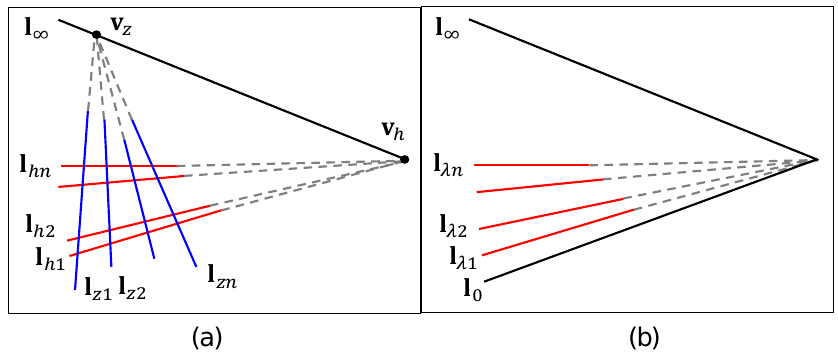
Figure 3. Vanishing line estimation: ( a ) method using vanishing points, ( b ) method using equally spaced parallel